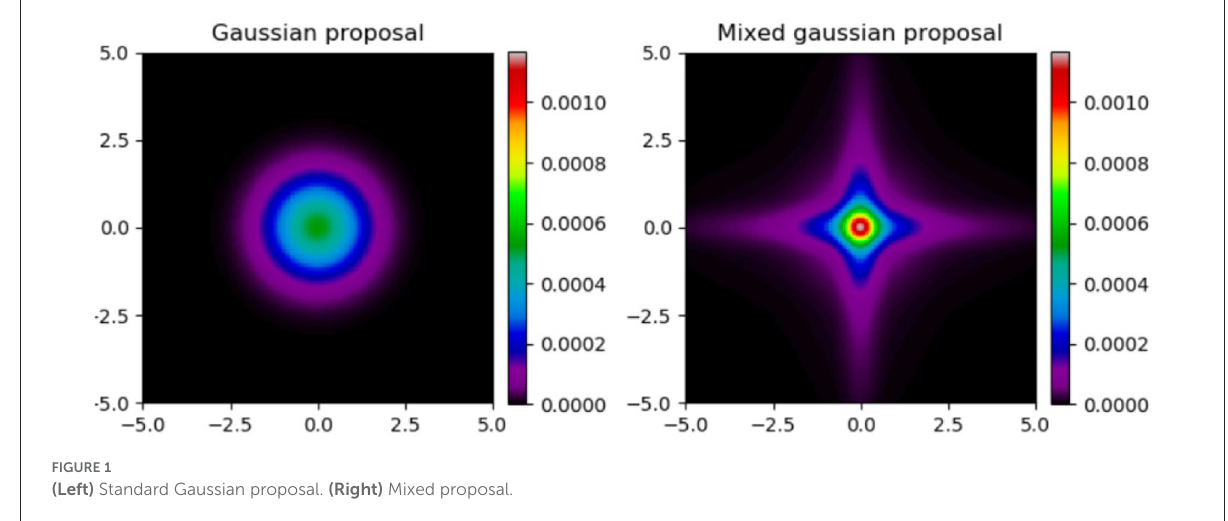
FIGURE1 (Left) Standard Gaussian proposal. (Right) Mixed